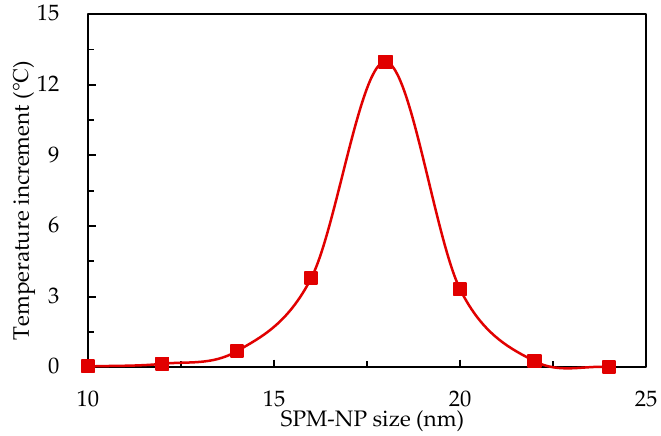
Figure 6. Effect of nanoparticle diameter on wax layer temperature increment (original wax layer temperature is 20 ◦ C, magnetic field frequency is 500 kHz, the electrical current intensity is 20 A, pig velocity is 0.4 m/s, the flow rate is 0.4 m/s, induction coil turn number is 310 turns, and nanoparticle content is